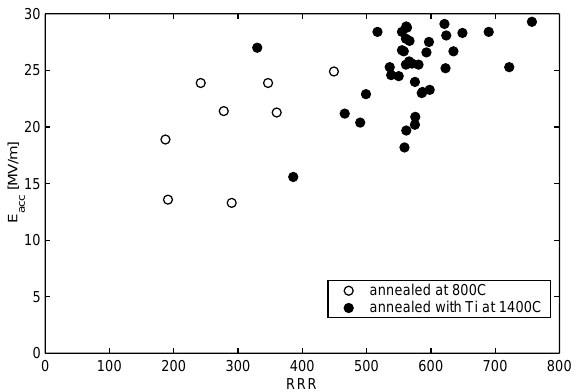
FIG. 23. Maximum gradient as a function of RRR.